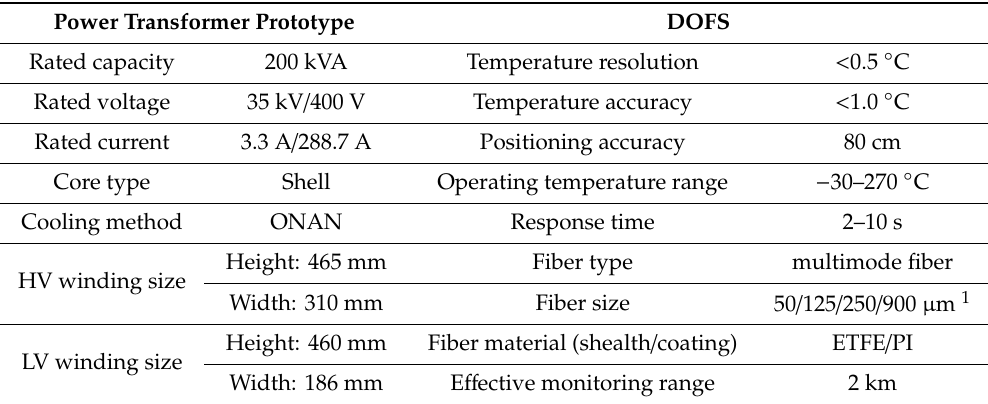
Table 1. Specifications of the transformer and the distributed optical fiber sensor